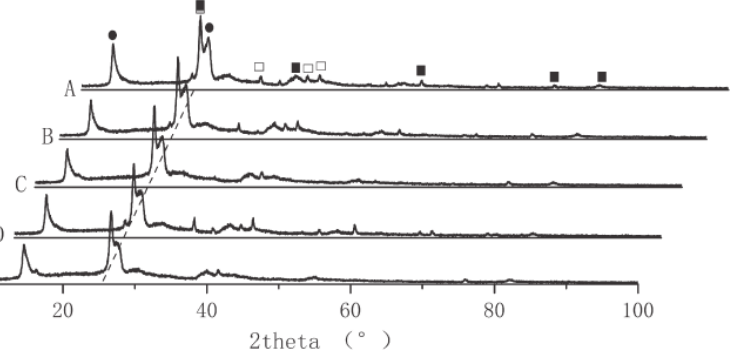
Fig. 4: XRD patterns of BN powder reacted with different H 2 O/air mass ratio at 1273 K for 18 h: (A) 0:100, (B) 1.5:100, (C) 3.5:100, (D) 5:100, (E) 6.5:100, (●) B O , (■) BN, (□) Al O 2 3 2 3